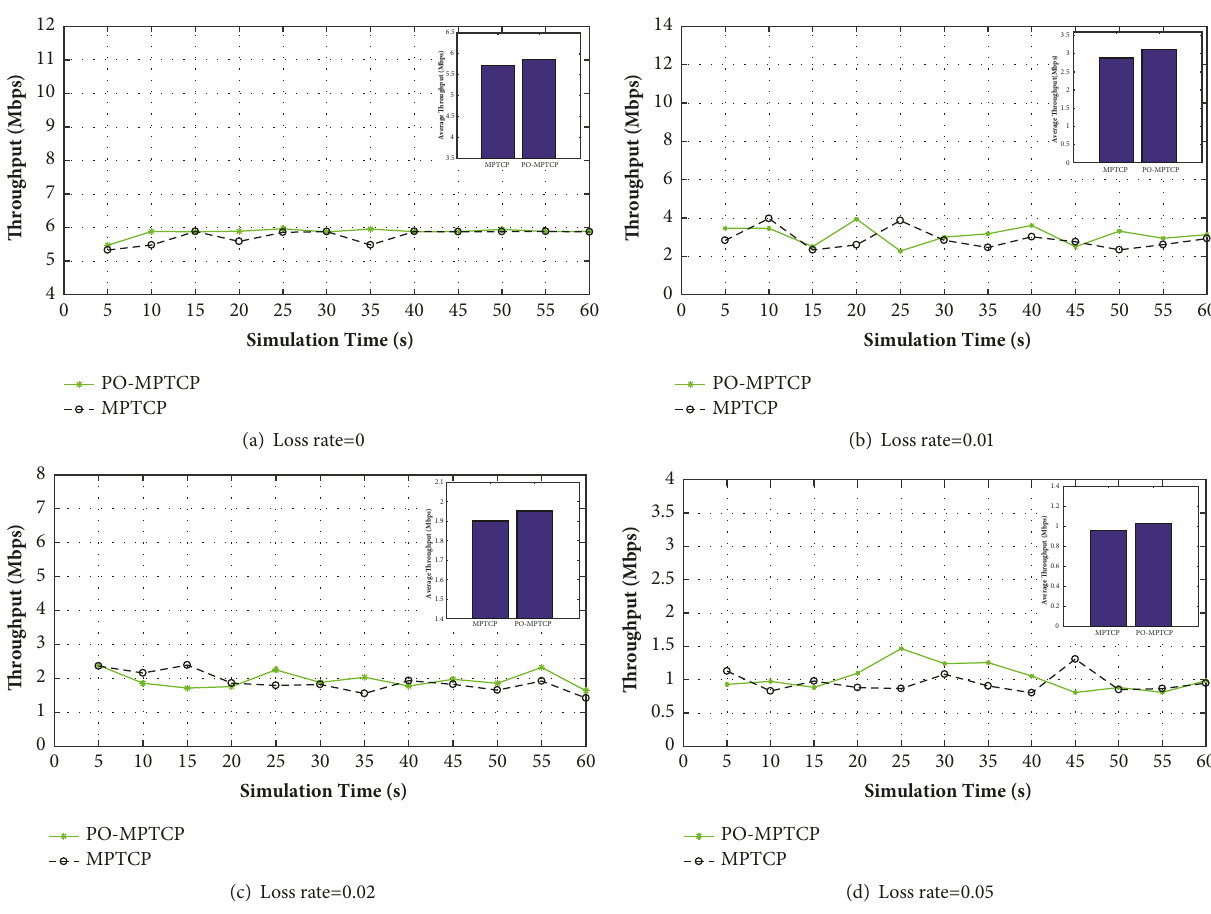
Figure 4: Comparison of throughput when (a) loss rate=0, (b) loss rate=0.01, (c) loss rate=0.02, and (d) loss rate=0.05.